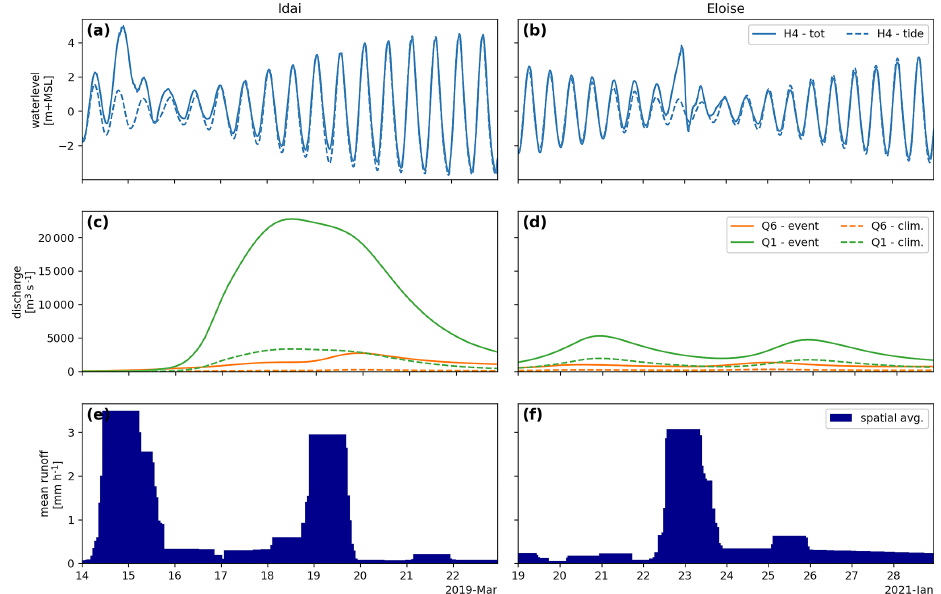
Figure 3. SFINCS boundary conditions during Tropical Cyclone Idai (a, c, e) and Tropical Cyclone Eloise (b, d, f) for the total sea level from GTSM and ERA5 (a, b) , discharge from CaMa-Flood (c, d) , and spatial average runoff from ERA5 (e, f) . The solid lines show the total water levels and discharge, as used for the validation; see Sect. 3.3.1. The dashed lines show the tidal water level component only (a, b) and normalized discharge to match the climatological mean (c, d) , as used in the compound driver analysis; see Sect. 3.3.3. Only one coastal location (H4) and the two main rivers (Q1 – Buzi and Q6 – Pungwe) are shown to improve the readability of the plots. The labels in the legends correspond to the boundary locations as shown in Fig.